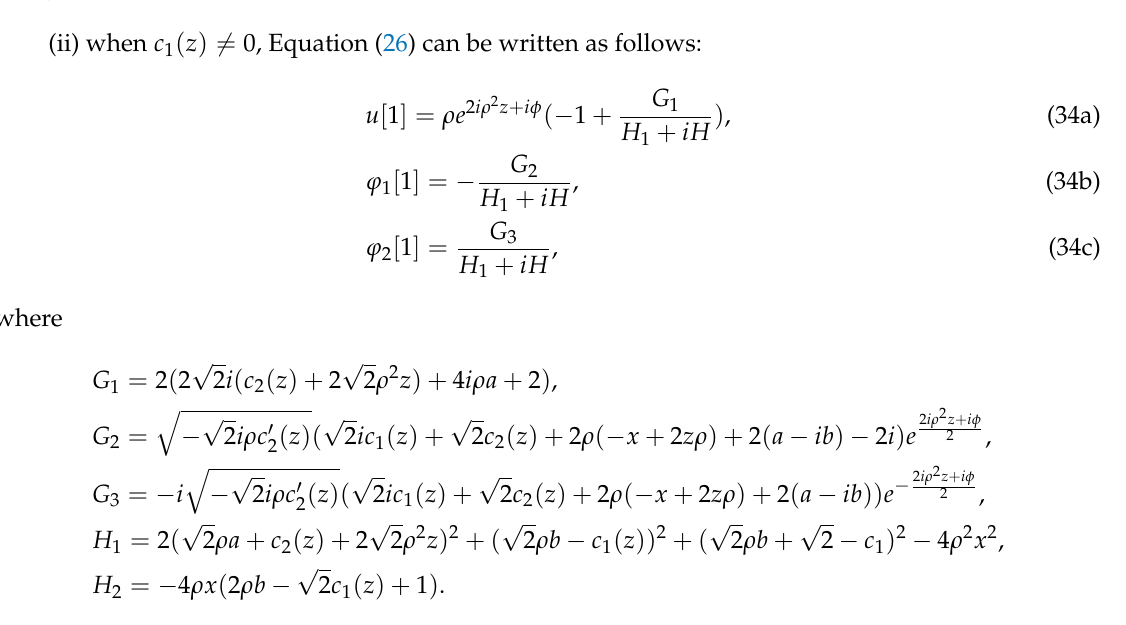
Figure 13. Degenerate two-solution interaction via the solution Equation (26a): ( a ) antidark soliton as z → ± ∞ , where ρ = 0.5, φ = 0, c ( z ) = z and γ 1 = 1 − 2 i ; ( b ) antidark soliton as z → ± ∞ , where ρ = 0.5, c ( z ) = z 2 and γ 1 = 1 − 2 i